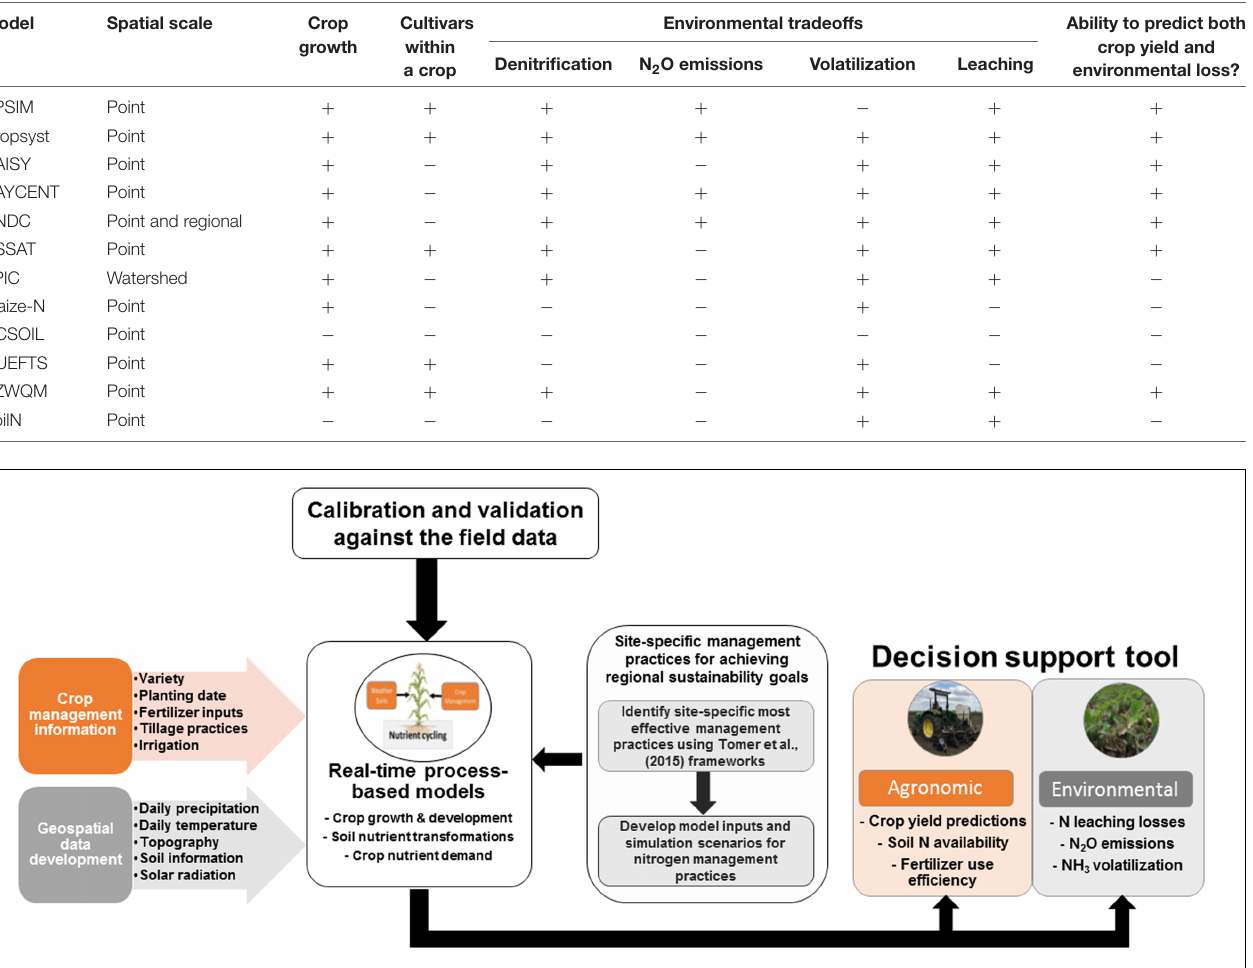
TABLE 1 | Status of the current public available crop models to estimate crop-growth and environmental tradeoffs. Model